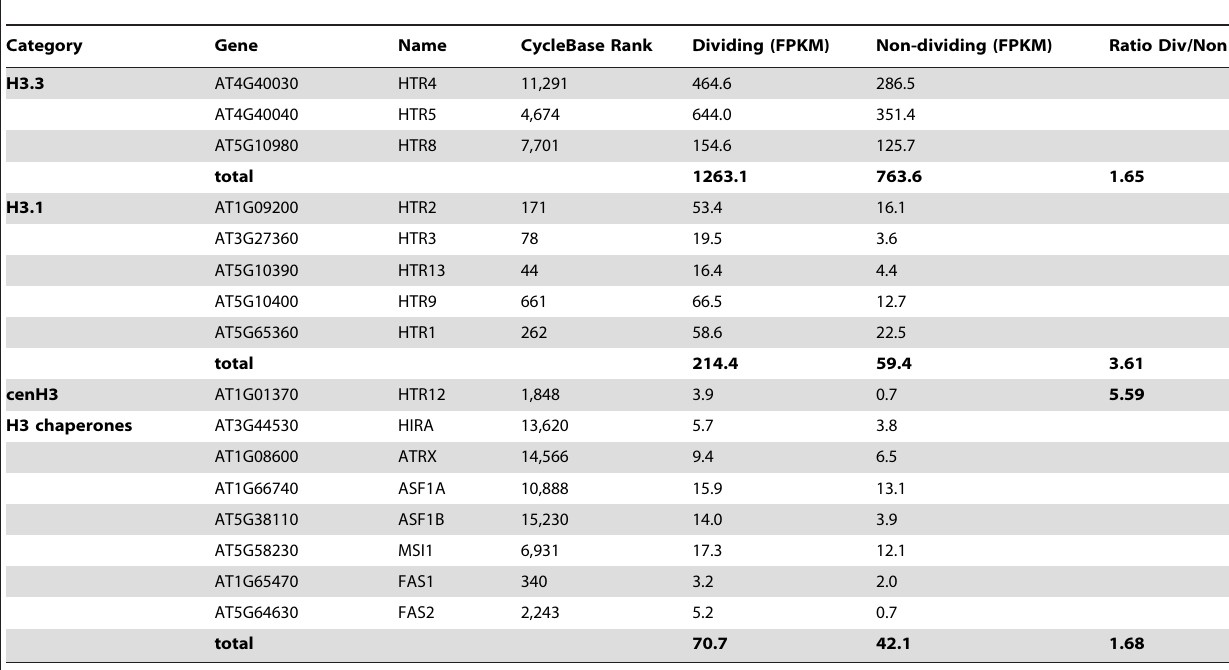
Table 1. Expression of histone H3 and potential histone H3 chaperone genes in dividing and non-dividing tissue.